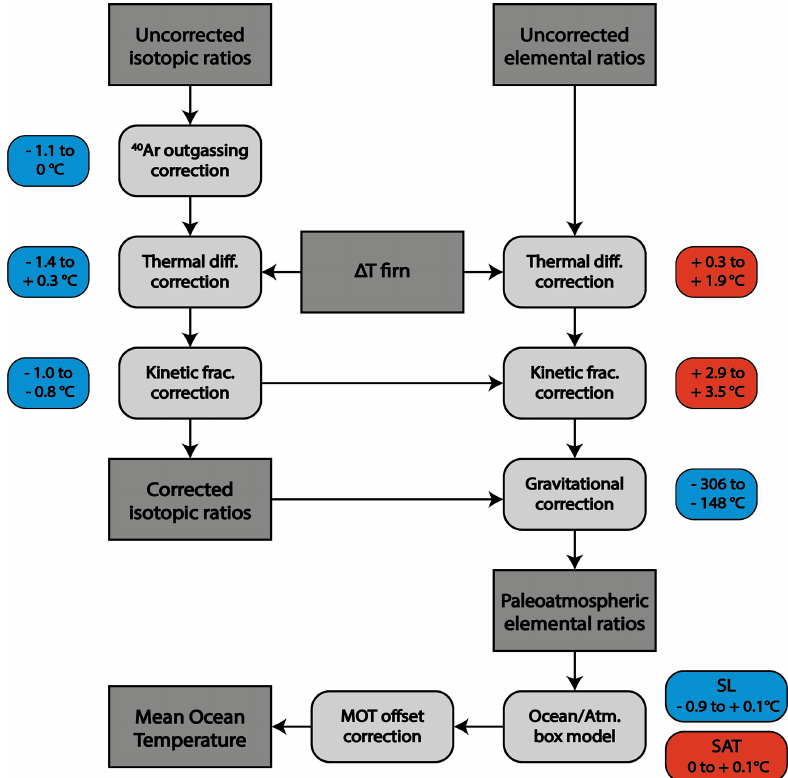
Figure 2. Flow scheme to infer paleo-atmospheric elemental ratios and finally MOT using the measured elemental ( δ Kr / N 2 , δ Xe / N 2 , and δ Xe / Kr) and isotopic ratios ( δ 40 / 36 Ar, δ 86 / 84 Kr, δ 136 / 129 Xe). Values are indicated by dark grey square boxes, while applied corrections are illustrated by rounded boxes in lighter grey. In a first step, the δ 40 / 36 Ar isotope ratios have to be corrected for changes in 40 Ar due to geological outgassing. The isotopic and elemental ratios are then corrected for thermal diffusion and kinetic fractionation. The temperature difference between the top and the bottom of the diffusive column height required for the correction of thermal diffusion is derived using either a firn column model (Michel, 2016) or the full matrix of noble gas isotopes. For the kinetic fractionation, we assume fixed ratios between isotopic and elemental ratios (Birner et al., 2018). Finally, the corrected isotopic ratios are used to correct the elemental ratios for the gravitational enrichment. The corrected elemental ratios are then translated into MOT using an ocean atmosphere box model. Here, we correct for the influences of sea level (SL) change and the saturation state (SAT) of the global ocean. In a last step, the resulting MOTs are corrected for their Holocene offset (see text for details). The approximate range of the respective correction performed on all our samples for MOT values can be found in the colored boxes. Positive values (red boxes) imply that the correction leads to an increase in absolute MOT values. It is important to stress that the size of the correction is not a measure of the uncertainty associated with it. The gravitational enrichment correction, for example, dominates all other corrections by orders of magnitude. Nonetheless, the analytical uncertainty of that correction is only minor, as it is largely given by the uncertainty in diffusive column height, the exact determination of which is one of our analytical foci. Also note that it is the size of the range of a correction, rather than the absolute value of the correction, that has an influence on glacial–interglacial MOT differences. For example, although the correction of elemental ratios for kinetic fractionation appears to be the second most influential correction, when considering its absolute value, its range is only narrow. Thus, it alters the glacial–interglacial MOT difference only